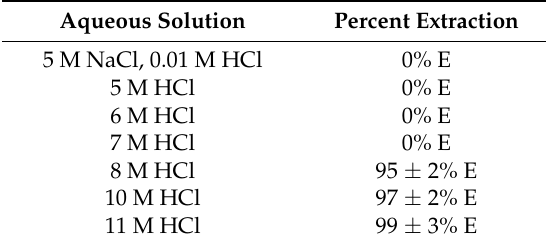
Table 4. The percent extraction of Eu from various HCl and NaCl aqueous solutions with 0.5 mole